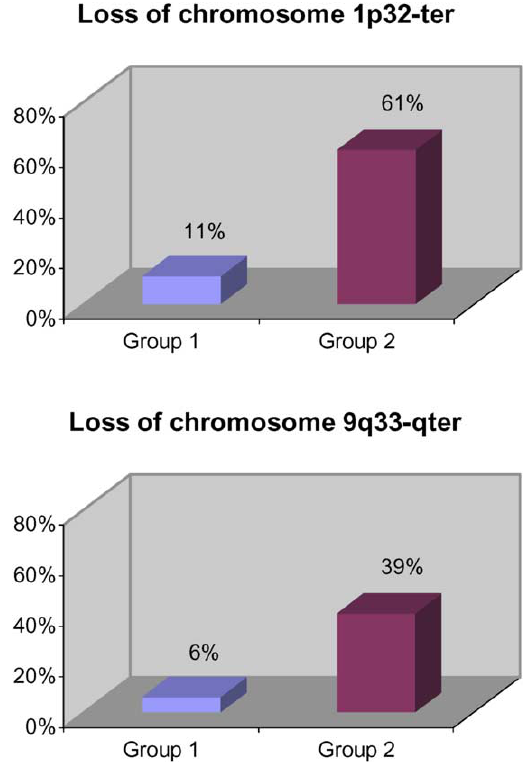
Fig. 3. Frequencies of sub-chromosomal imbalances in metastatic (group 2) and non-metastatic (group 1) colorectal cancers. distinct chromosomal losses which were present at much higher frequencies in metastatic than in non- metastatic cancers, losses of 1p32-ter ( P = 0 . 02) and 9q33-ter ( P = 0 . 04), respectively (Fig. 3). Of note, chromosomal gains with higher frequencies in metastatic cancers could only be mapped to chromo- some 5p ( P = 0 .